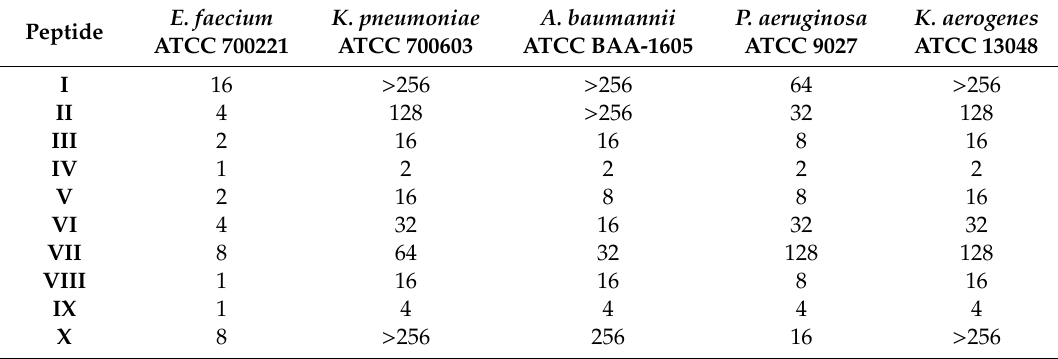
Table 2. The minimal inhibitory concentration (MIC) values ( µ g / mL) of the peptides against reference strains of ESKAPE pathogens.